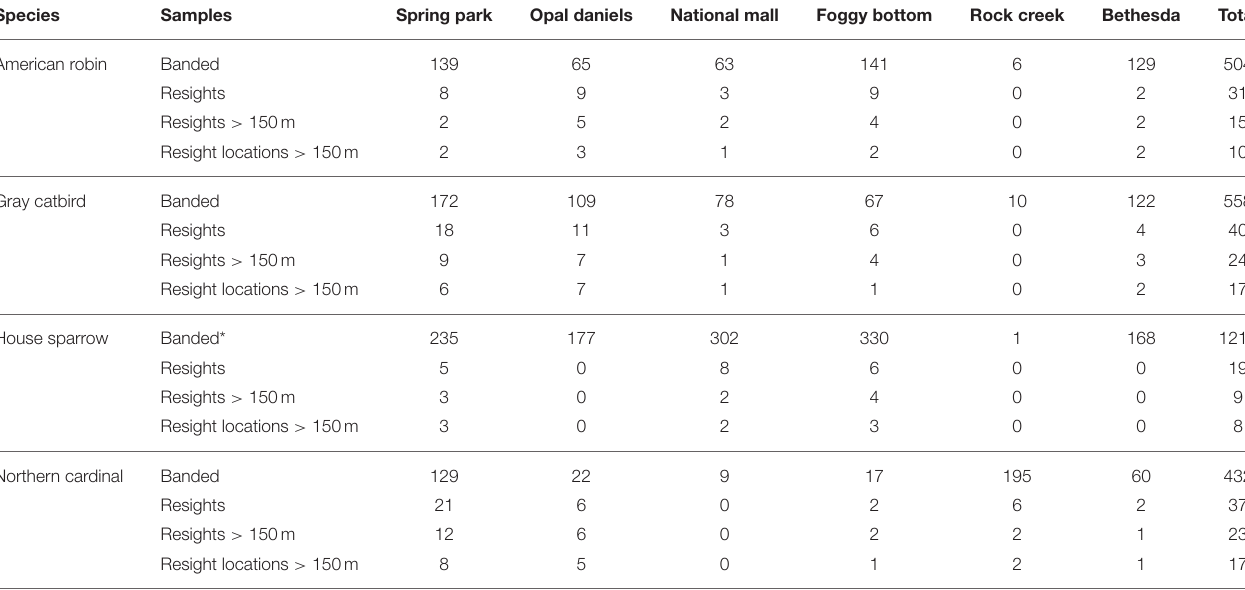
TABLE 1 | Samples of focal species across each of the six banding stations. Species Samples Spring park Opal daniels National mall Foggy bottom Rock creek Bethesda Total American robin Banded 139